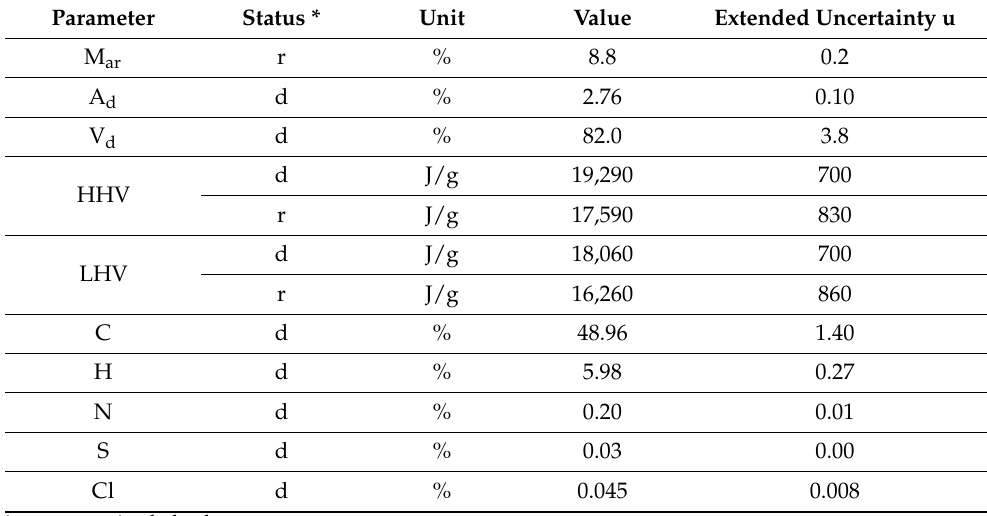
Table 4. Giant miscanthus biomass parameters important from the energetic point of view.